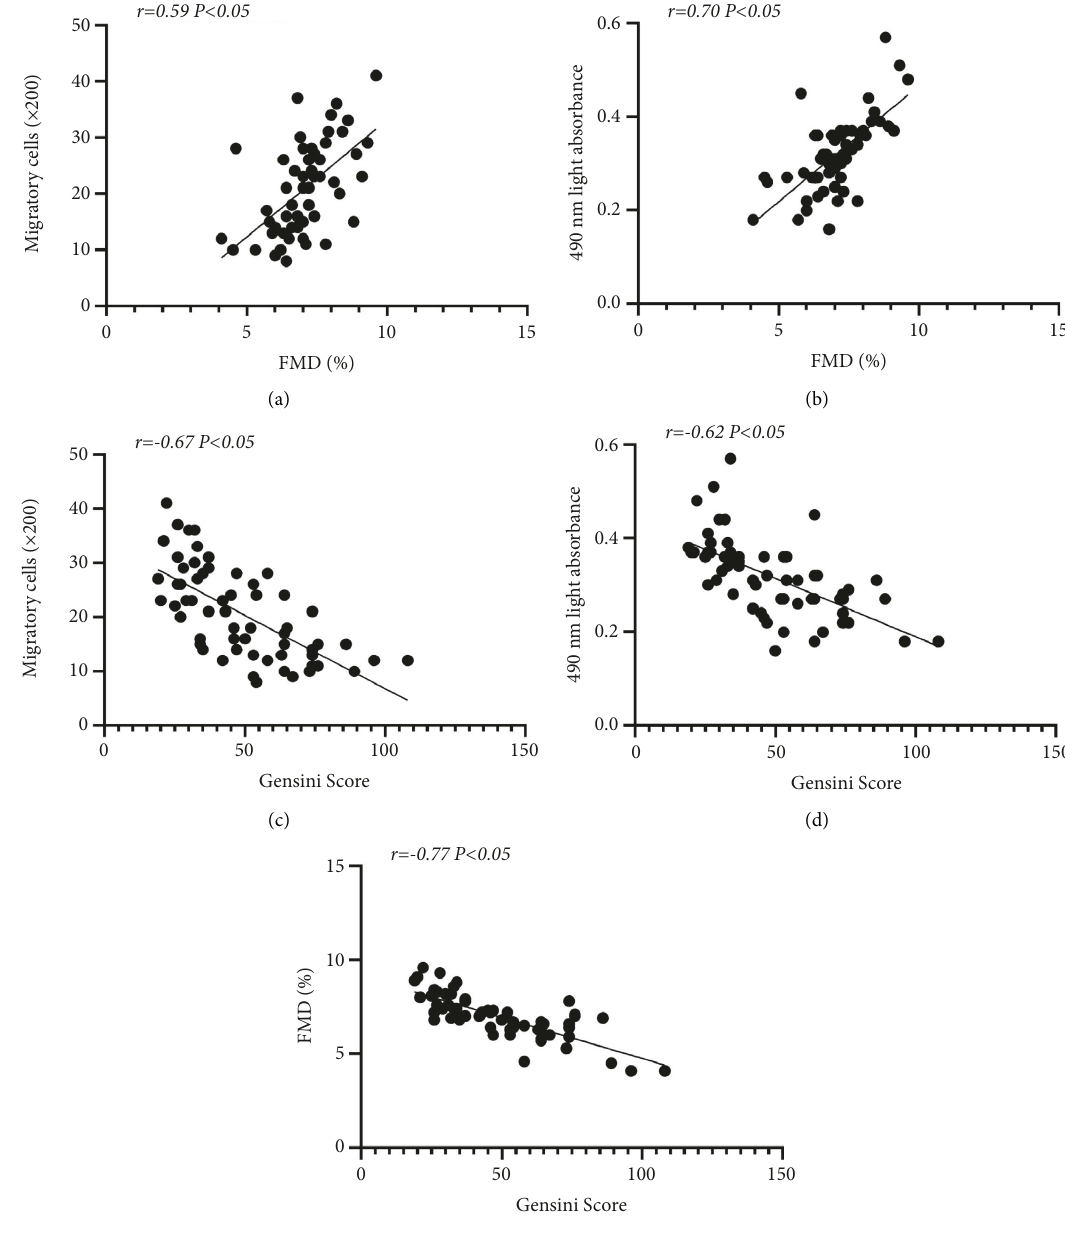
Figure 3: Correlation between FMD and the Gensini score and EPC function. FMD was positively correlated with EPC migration (a) and proliferation (b) In addition, the Genisini score was inversely related to EPC migration (c) and proliferation (d) And the Genisini score was inversely related to FMD (e) Univariate correlations were calculated using Pearson’s coefficient ( r